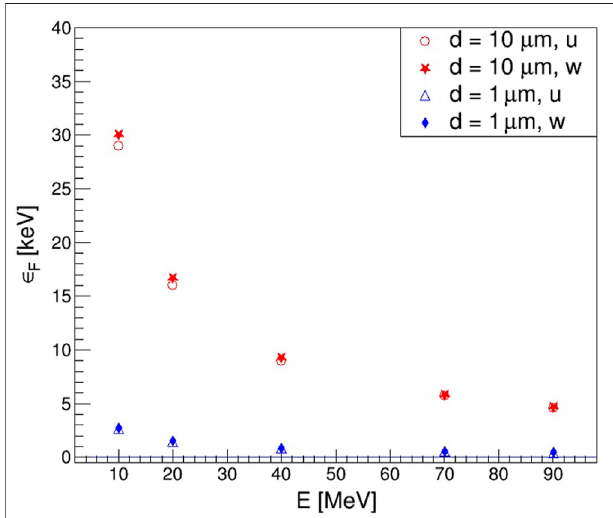
FIGURE 5 | Frequency-averaged energy imparted per event (cid:1) ϵ sF as a function of the proton energy. Uniform (open markers) and weighted (full markers) random sampling results are plot together and compared for sites of 1 (blue triangles and diamonds) and 10 μ m (red circles and stars)